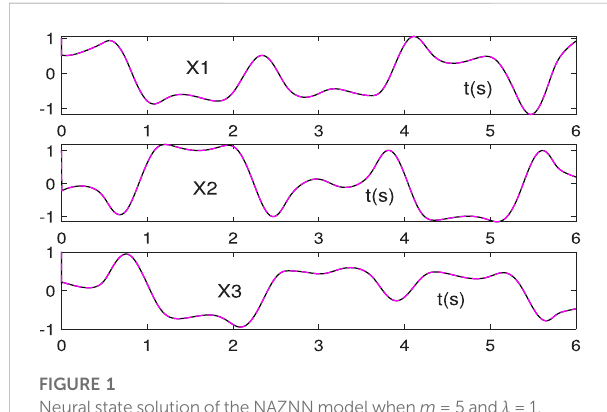
FIGURE 1 Neural state solution of the NAZNN model when m = 5 and λ = 1.